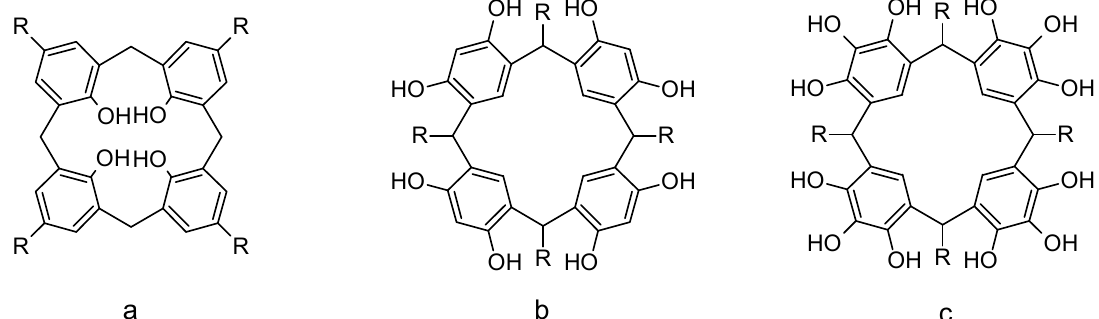
Figure 1. Polyhydroxylated plataforms. ( a ) Calix[4]arene; ( b ) resorcinarene; ( c ) pyrogalloarene.